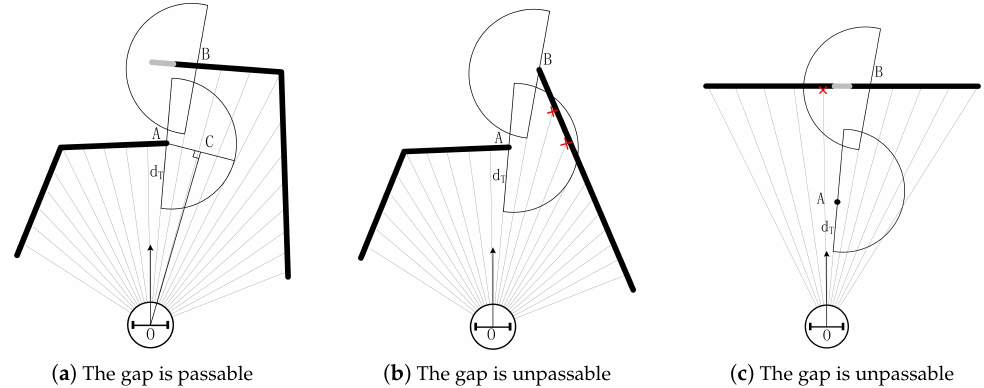
Figure 4. Examples of gaps. The black objects are obstacles that can be detected by LIDAR, and the gray objects are obstacles that cannot be